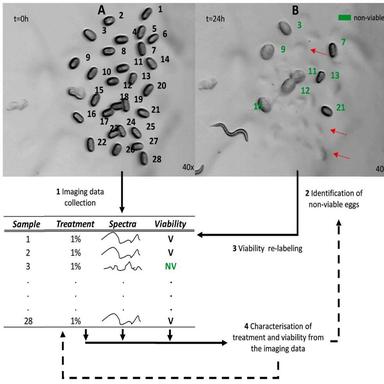
Example of the egg viability determination and imaging processing scheme. A: eggs newly extracted after the synchronisation procedure. B: non-viable eggs 24 h after the synchronisation procedure. V: viable egg; NV: non-viable egg.